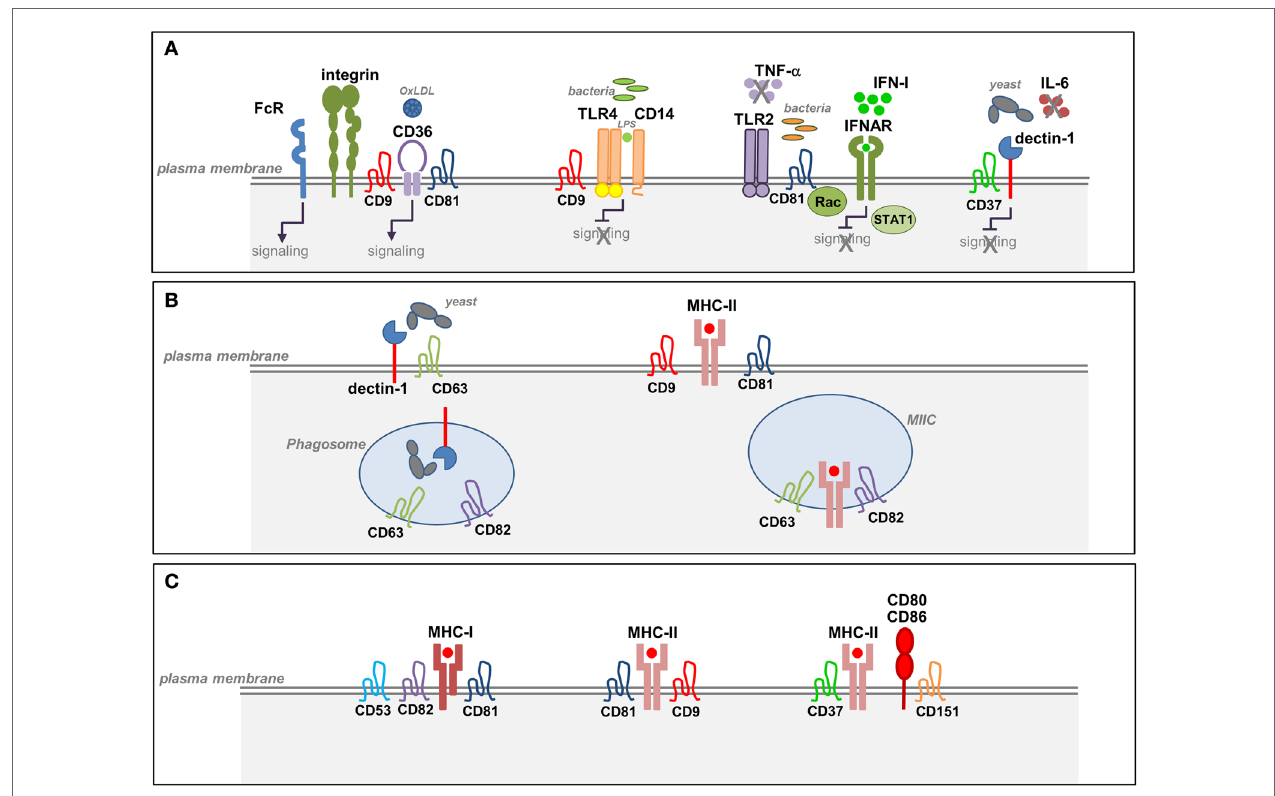
FiGURe 1 | Tetraspanins in the function of APCs . (A) Tetraspanin interactions with pathogen-recognition receptors (PRRs) in APCs. Tetraspanins interact with specific PRRs at the plasma membrane of macrophages and DCs. CD37 associates with dectin-1 and inhibits dectin-1 mediated IL-6 production triggered by the recognition of fungal cell walls. CD9 forms a complex with CD14 and TLR4 and negatively regulates TLR4 signaling in response to LPS. CD81–Rac interaction inhibits TLR2- and IFNAR-signaling pathways and prevents the subsequent activation of STAT1 in response to Listeria monocytogenes . CD36 associates with β 1 and β 2 integrins and tetraspanins CD9 and CD81 forming a complex that facilitates CD36-signaling and its interaction with Fc γ Rs. Interaction between CD9 and Fc γ Rs promotes phagocytosis and macrophage activation. (B) Tetraspanin interactions during Ag processing and MHC-II biosynthesis. CD63 interacts with dectin-1 in immature DCs and promotes yeast phagocytosis. Both CD63 and CD82 are selectively recruited to yeast-containing phagosomes. CD82 and CD63 are highly enriched in MIIC compartments that contain newly synthesized MHC-II and accessory proteins. (C) Tetraspanin interactions during Ag presentation. Several tetraspanins associate with MHC-I and MHC-II molecules on APCs. Tetraspanins CD9, CD53, CD81, and CD37 associate with MHC-II molecules preferentially at the plasma membrane. MHC-II molecules loaded with a restricted antigenic peptide repertoire are included in TEMs together with accessory molecules and costimulatory molecules. CD9 facilitates MHC-II clustering, and CD151 is involved in the clustering of costimulatory